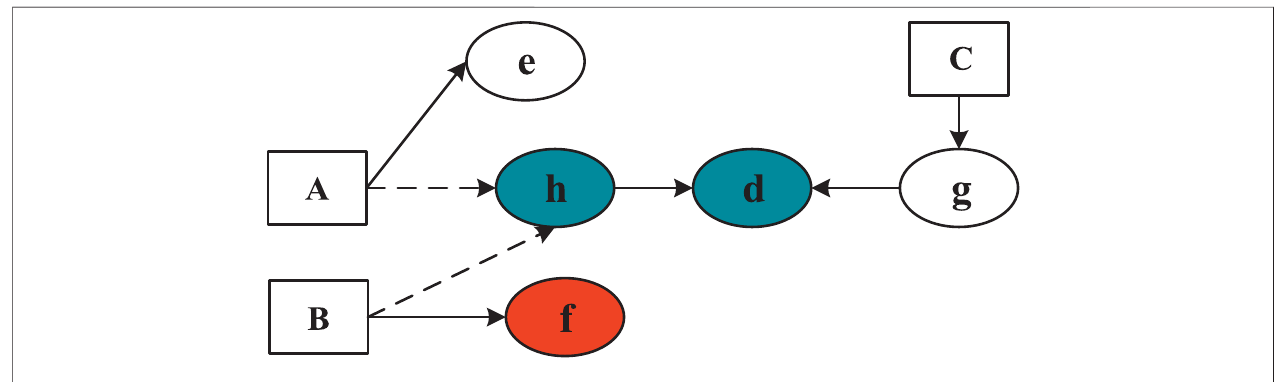
FIGURE 3 | Example of an SDG